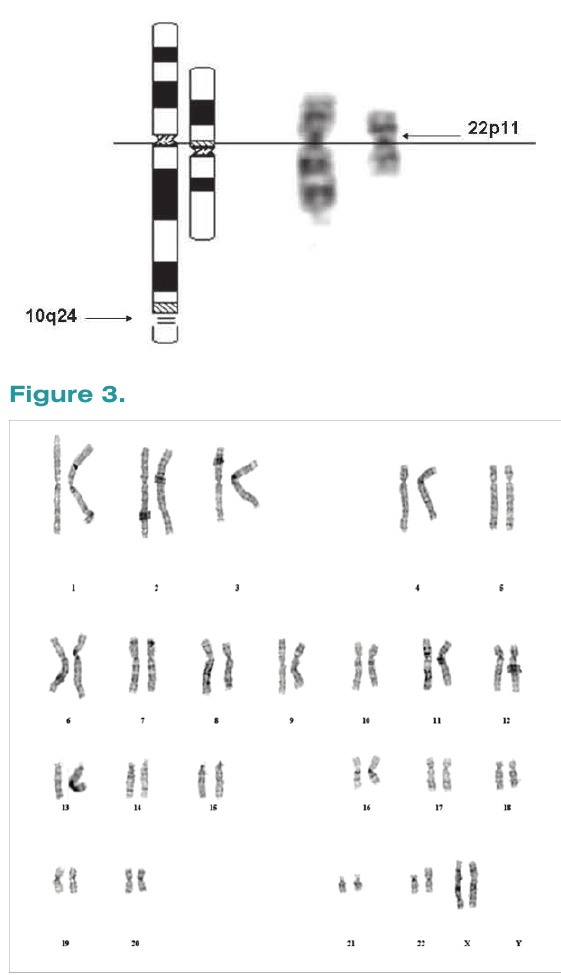
Figure 2. Ideogram of the balanced t(10;22). The arrows show the breakpoints on 10q24 and 22p11